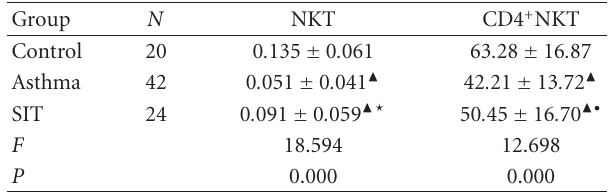
Table 2: The ratio of peripheral blood NKT and CD4 + NKT cells in asthma patients and control group ( x ± sd).